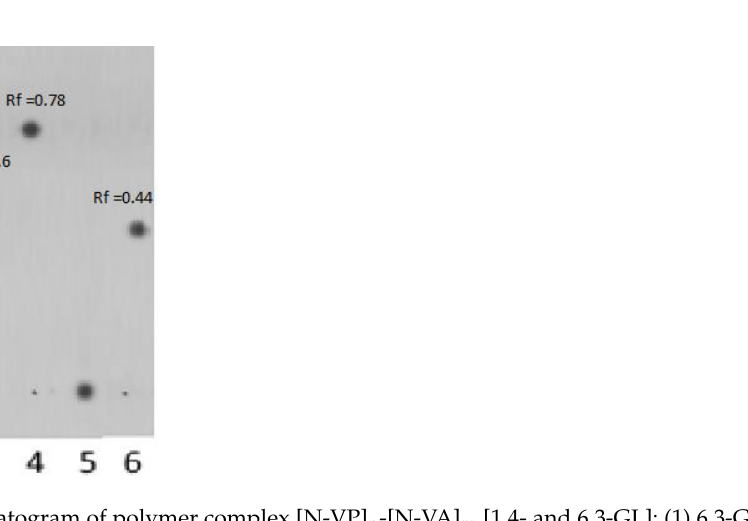
Figure 6. TLC chromatogram of polymer complex [N-VP] n -[N-VA] m [1,4- and 6,3-GL]: (1) 6,3-GL; (2) polymer complex after dialysis; (3) sample 2 after prolonged storage at t = 23 °C; (4) 1,4-GL; (5)